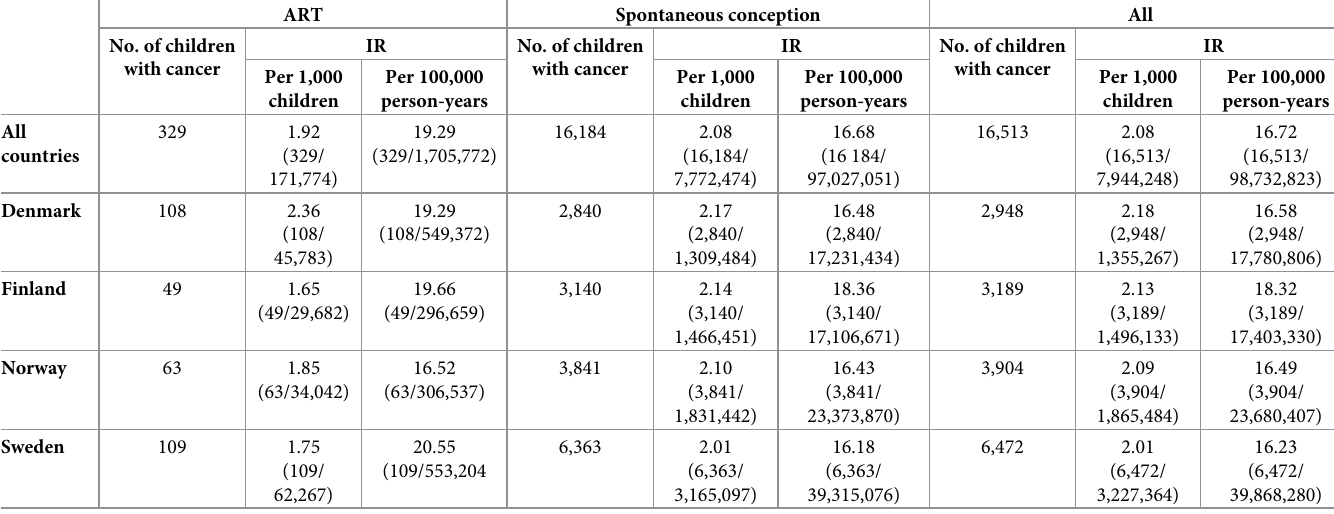
Table 2. IR of any cancer before 18 years of age by mode of conception and country of birth in children born in Denmark, Finland, Norway, or Sweden (Denmark 1994–2014, Finland 1990–2014, Norway 1984–2015, and Sweden 1985–2015).